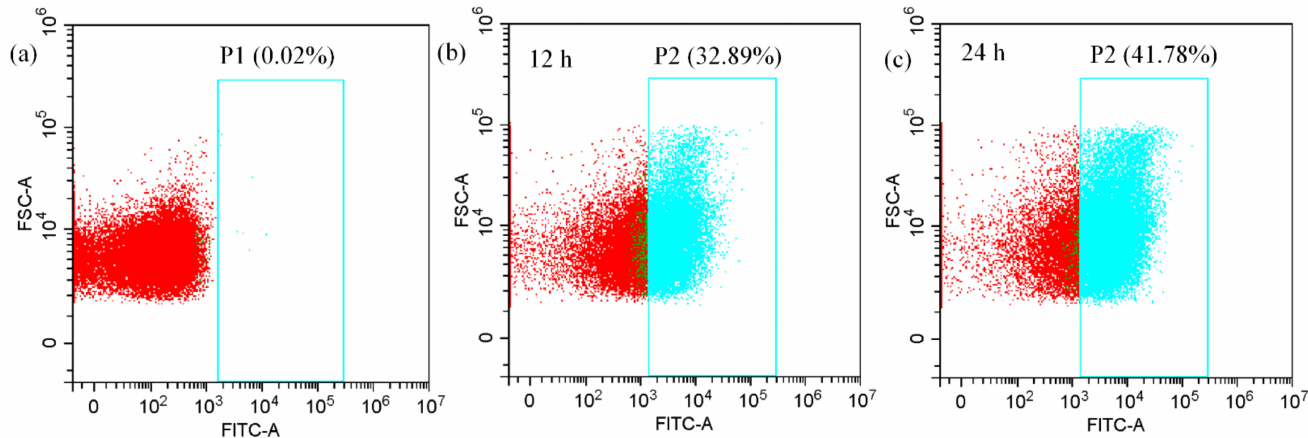
Figure 9. Proportion of wh-CQDs internalized in Klebsiella sp. by flow cytometry analyses. ( a ) without wh-CQDs, ( b ) Klebsiella sp. cells incubated with wh-CQDs (500 mg/mL) for 12 h and ( c ) 24